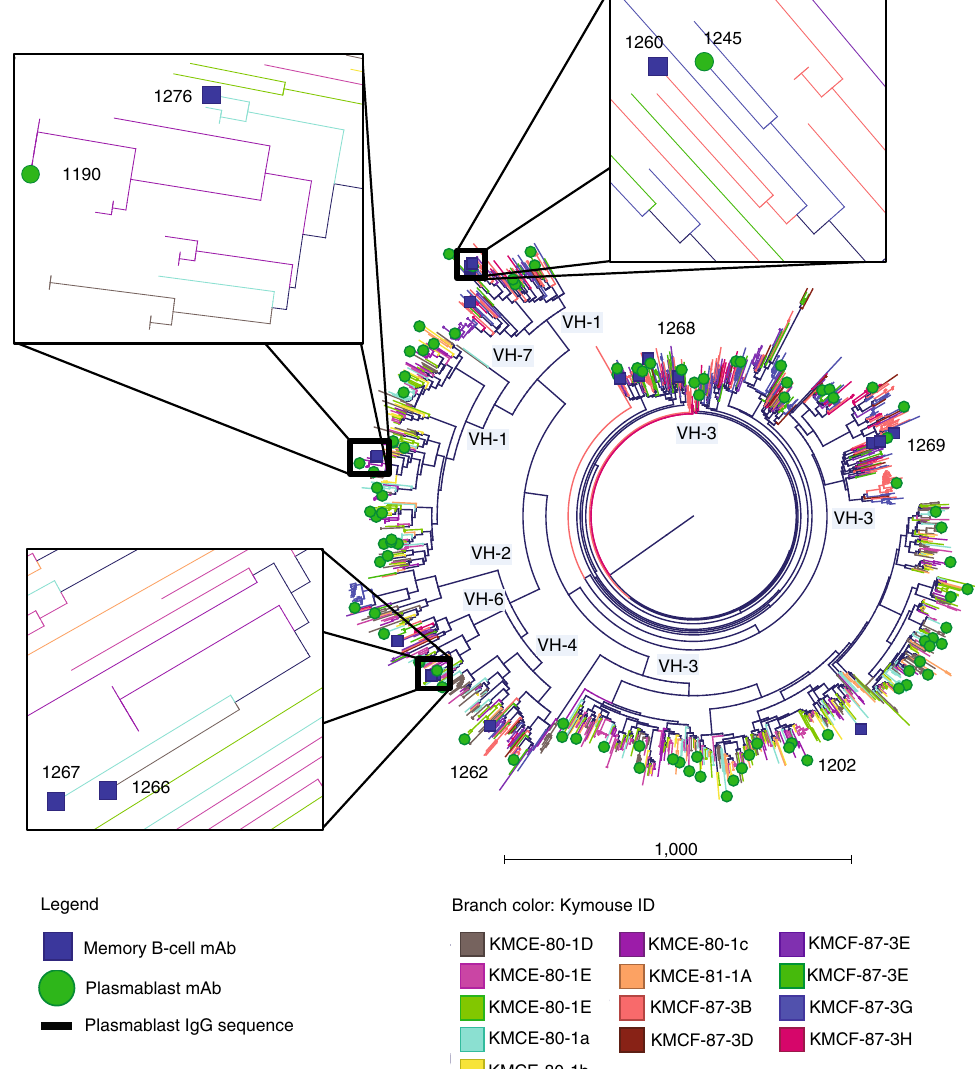
Fig. 1 Phylogram representation of B-cell responses to Pfs25-VLP immunization. Natively paired H- and L-chain, full-length, variable region sequences from 13 Pfs25-VLP-immunized Kymice were combined into one phylogram based on full-variable region H- and L-chain amino acid sequence similarity among plasmablast IgG and memory B-cell IgG sequences. The 95 plasmablast-derived and 18 memory B-cell-derived sequences selected for recombinant antibody expression are noted as green circles and blue boxes, respectively. Recombinant antibodies listed in Table 1 chosen for further analysis are labeled. Between pairs of nodes, sum of radial distances is proportional to the Kimura distance as indicated by the scale bar. Branch color denotes the speci fi c animal from which the sequence was derived. Higher magni fi cation insets show cases in which two different anti-Pfs25 antibodies of highly similar sequence originate from different individual Kymice and, in two cases, different antibody-expressing cell types. The subset of plasmablast sequences from Pfs25-VLP immunized Kymice that are similar to sequences from empty VLP-immunized Kymice are included as part of the 1564 plasmablast data set shown in the tree, but were not used as sources for recombinant antibody